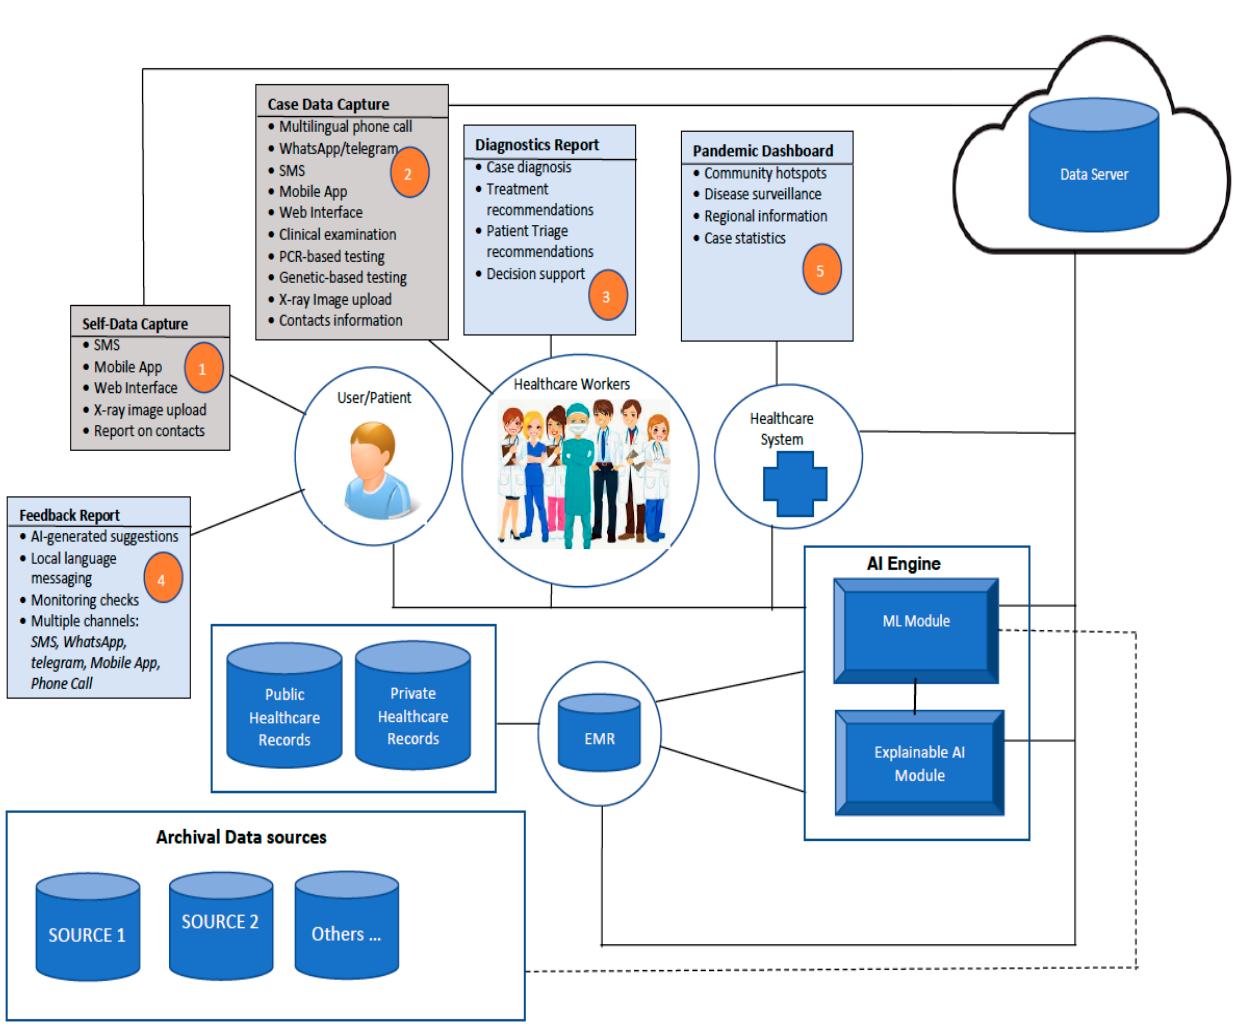
Figure 1. The architecture of the proposed framework for multimodal diagnostics and management of COVID-19 and comorbidities.